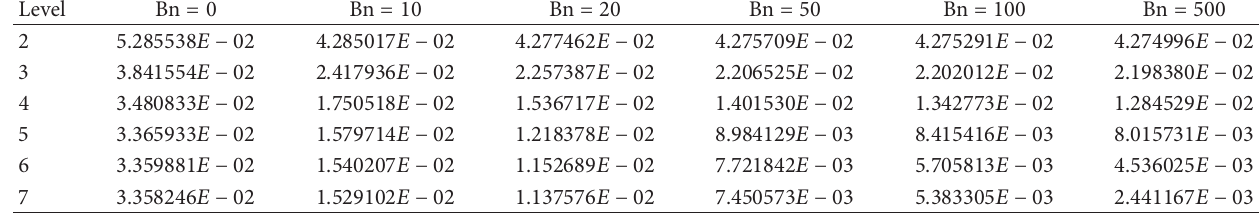
Table 2: Kinetic energy at different refinement levels for different Bingham numbers.